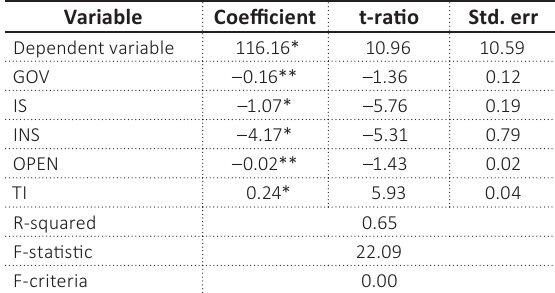
Table 4. Regression results, 2012–2020